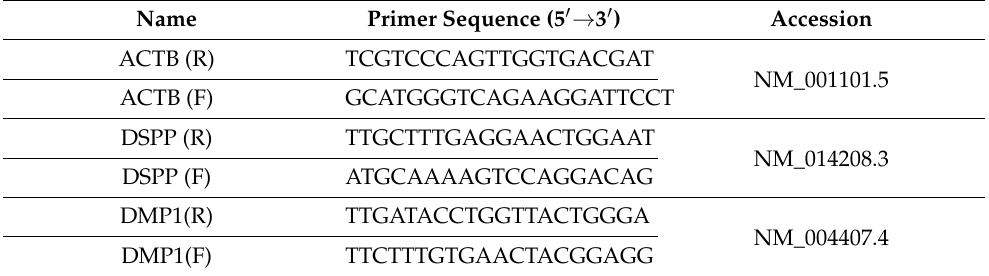
Table 1. Primers used for